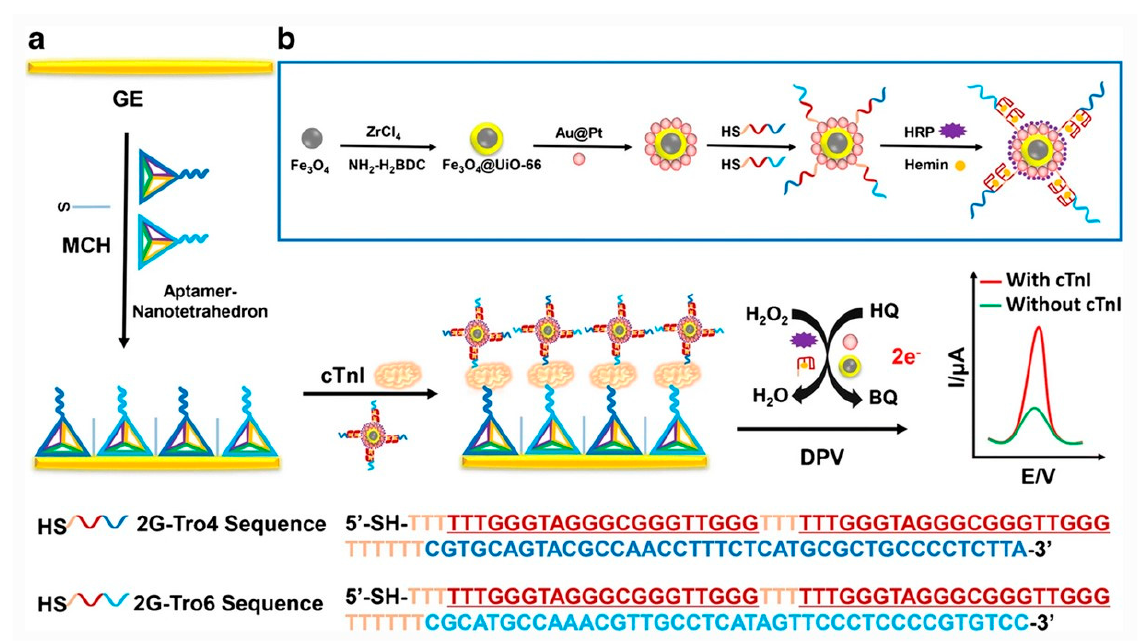
Figure 6. Schematic of the electrochemical sandwich assay for cardiac troponin I (cTnI) in which the capture aptamer is a thiolated DNA nanotetrahedron with one aptamer strand. The detection aptamer is bound to Au@Pt nanoparticles around magnetic metal organic framework (Fe 3 O 4 @UiO-66) particles bound to Tro4 and Tro6 aptamers along with G-quadruplex/hemin (GQH) DNAzyme and horseradish peroxidase (HRP). Pathway ( a ) shows the steps for the modification of the screen-printed gold electrodes with DNA nanotetrahedrons presenting the Tro4 aptamer, the formation of the sandwich structure with cTnI and the modified Fe 3 O 4 nanoparticles presenting the Tro6 aptamer and enzymes. The sequences for Tro4 and Tro6 are shown at the bottom of the figure. Pathway ( b ) shows the steps for the production of the Tro6 modified aptamer-labeled nanoparticles and enzymes for detection. Reproduced with permission from [64]. Copyright Springer